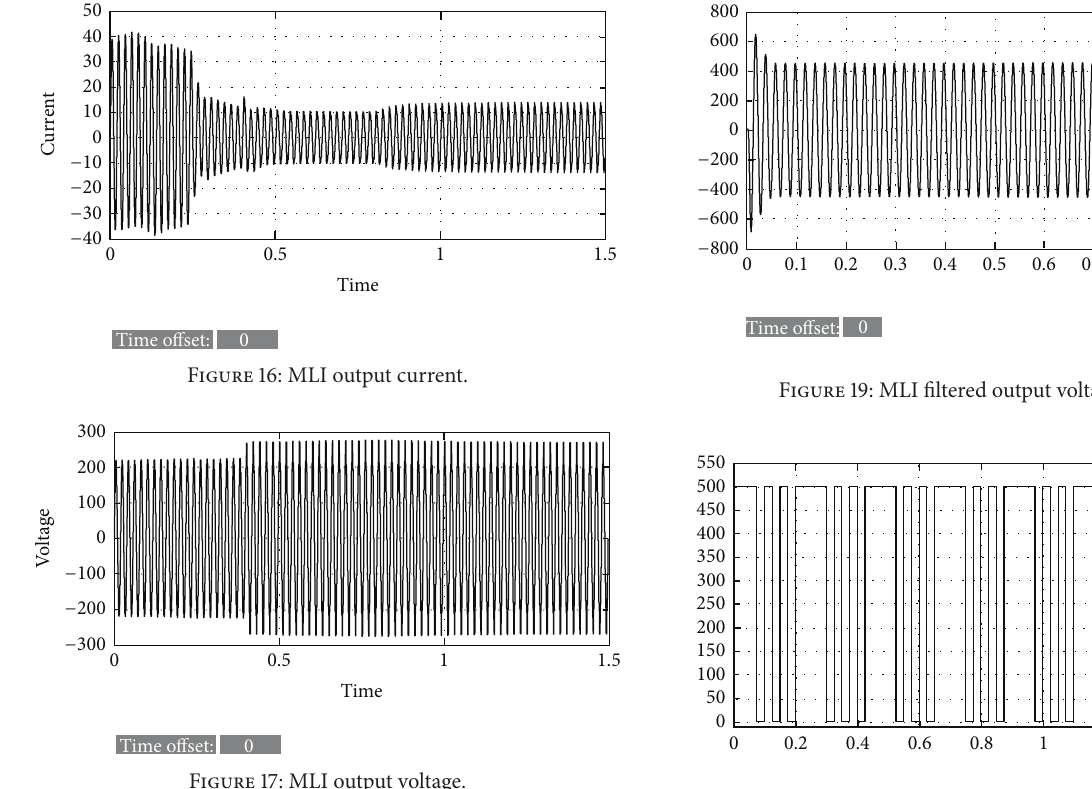
Figure 17: MLI output voltage.